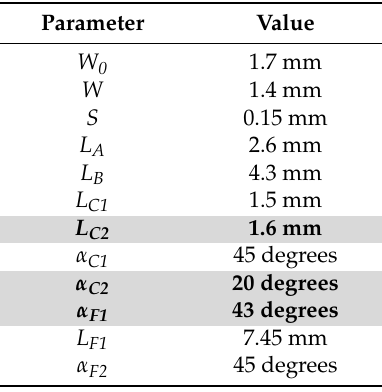
are reported in bold.